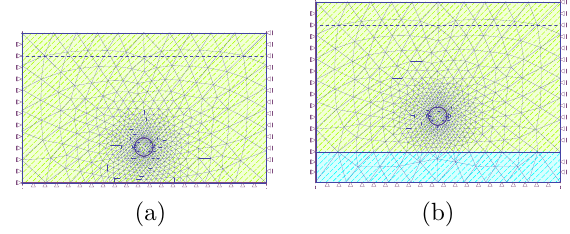
Figure 1. Geometrical model: a) Model-1 - one layer, b) Model-2 - two layers.